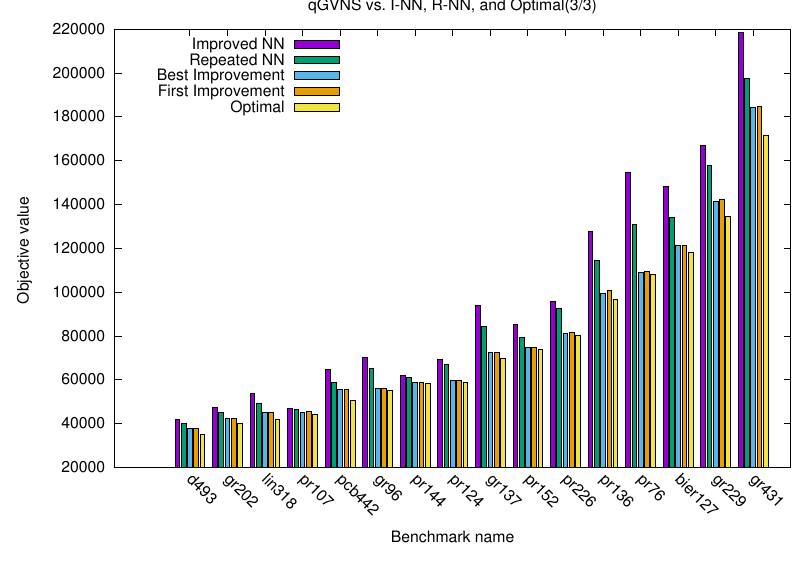
Figure 6. NN variants vs. GVNS vs. OV